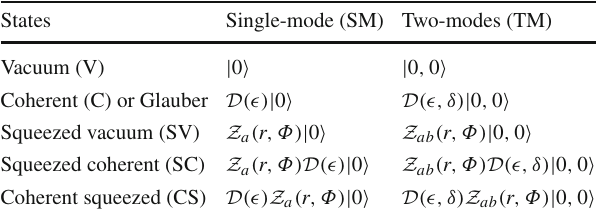
Table 1 Encapsulation of the feasible non-classical states States Single-mode (SM) Two-modes